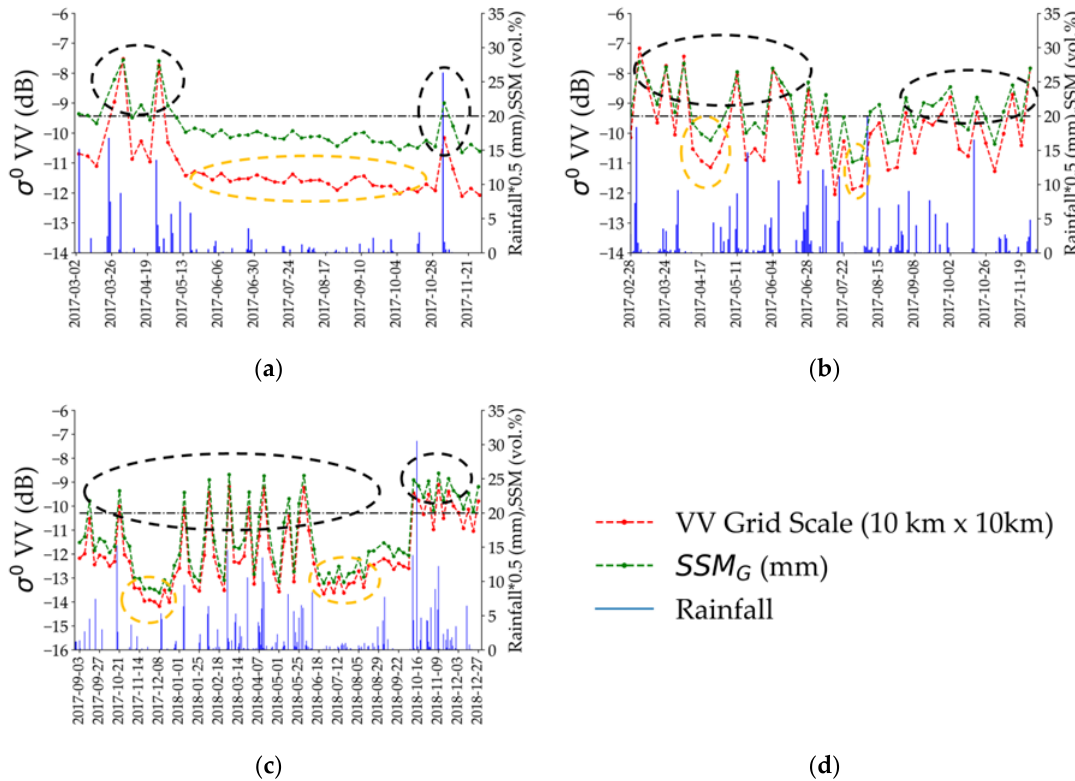
Figure 4. Temporal evolution of Synthetic Aperture Radar (SAR) backscattering coe ffi cient σ ◦ in VV polarization at 10 km grid scale (red curve) with surface soil moisture (SSM) estimation at 10 km grid scale (green curve) and daily precipitation data from the Global Precipitation Mission (GPM) mission (blue curve) for ( a ) Montpellier, ( b ) Tarbes and ( c ) Catalonia. Black dashed circle corresponds to existing rainfall events while yellow circle shows the absence of